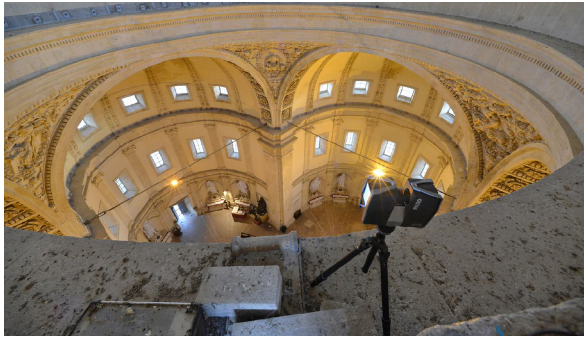
Figure 10. Internal scan from the dome